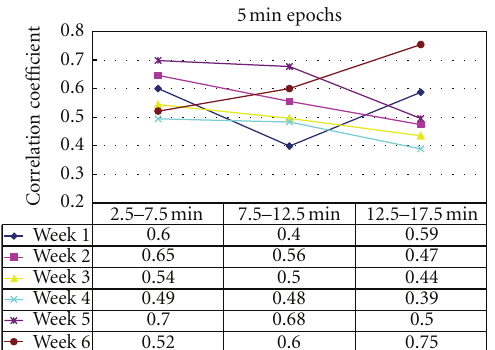
Figure 3: Pearson correlation coe ffi cients of 6 weeks for 5-minute epochs.